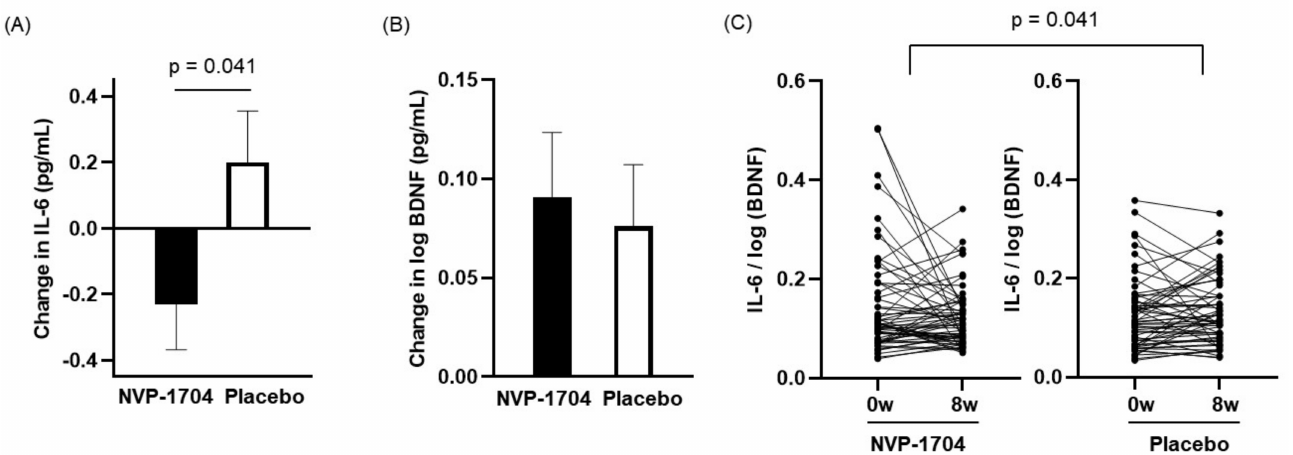
Figure 5. Effect of NVP-1704 on blood levels of IL-6, BDNF, and the ratio of IL-6 to log (BDNF). ( A ) Changes in the level of IL-6 and ( B ) log (BDNF) in serum from baseline to 8 weeks of treatment. ( C ) The ratio of IL-6 to log (BDNF) as individual values at each time point in the NVP-1704 and placebo groups. IL-6, interleukin-6; BDNF, brain-derived neurotrophic